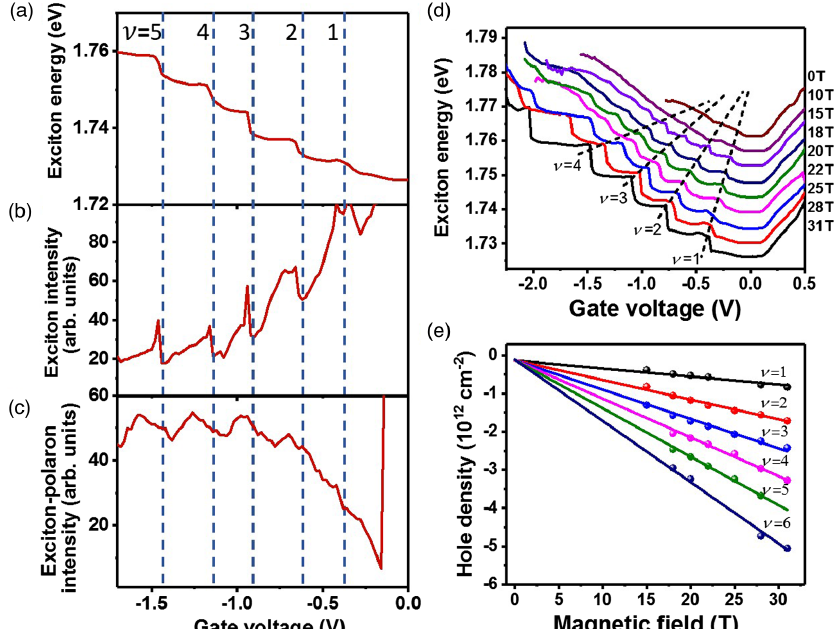
FIG. 4. Quantized exciton energy and spin- and valley-polarized LLs. (a) Under the out-of-plane magnetic field of 25 T, the reflectance spectra local maximum position was tracked as a function of the gate voltage. The exciton resonance energy as a function of the gate voltage for different LL filling factors exhibits a ladder of plateaus. (b) Integrated exciton differential reflectance intensity as a function of the gate voltage for different filling factors. (c) Integrated reflectance intensity for the exciton-polaron as a function of the gate voltage for different filling factors. (d) Exciton resonance energy as a function of the gate voltage for different magnetic field applied. The plateau feature starts to develop when the magnetic field exceeds 15 T. For each curve in different magnetic fields, we shift the energy of each curve by 4 meV for clarity. (e) The required hole density to completely fill the LL with the filling factor from 1 to